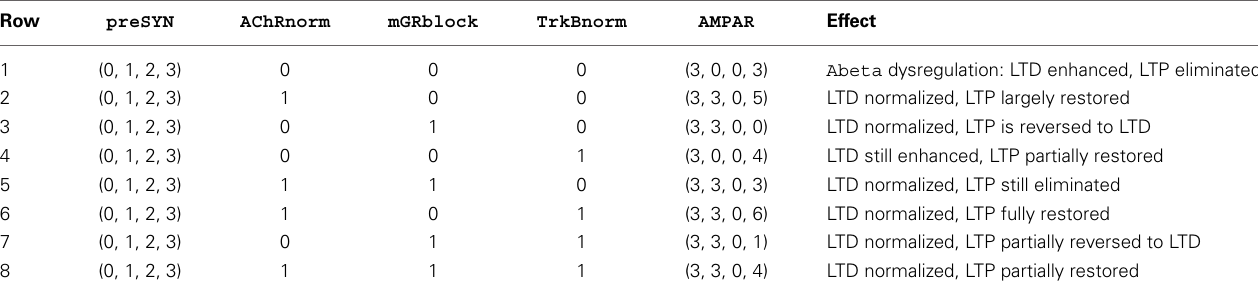
Table 4 | Effects on synaptic plasticity of compounds that modify receptor